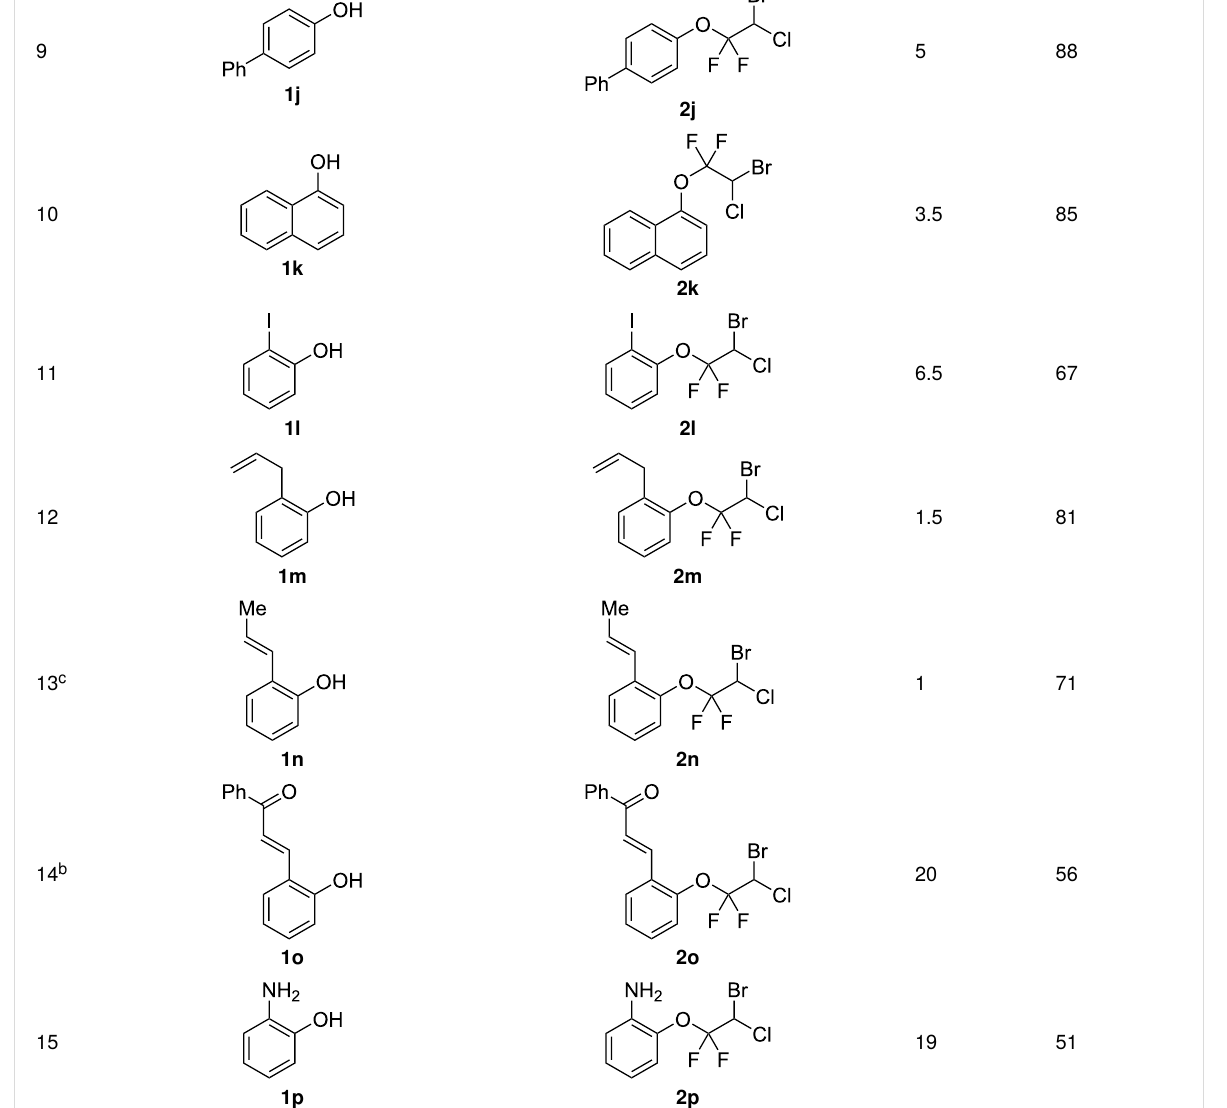
Table 2: The reaction scope with various phenols. (continued)